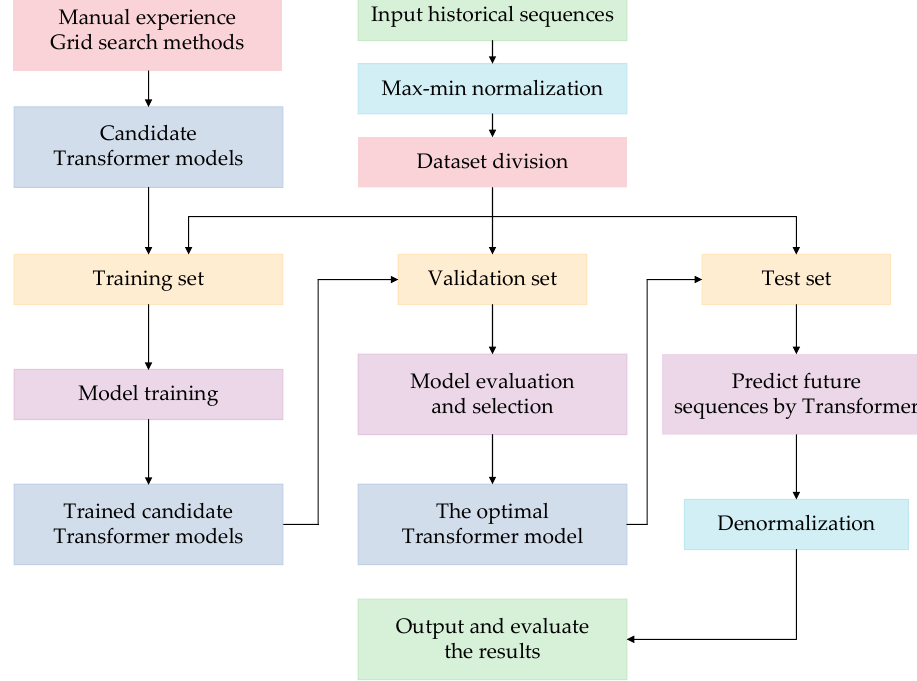
Figure 5. Flowchart of Transformer-based prediction of independent operation variables.